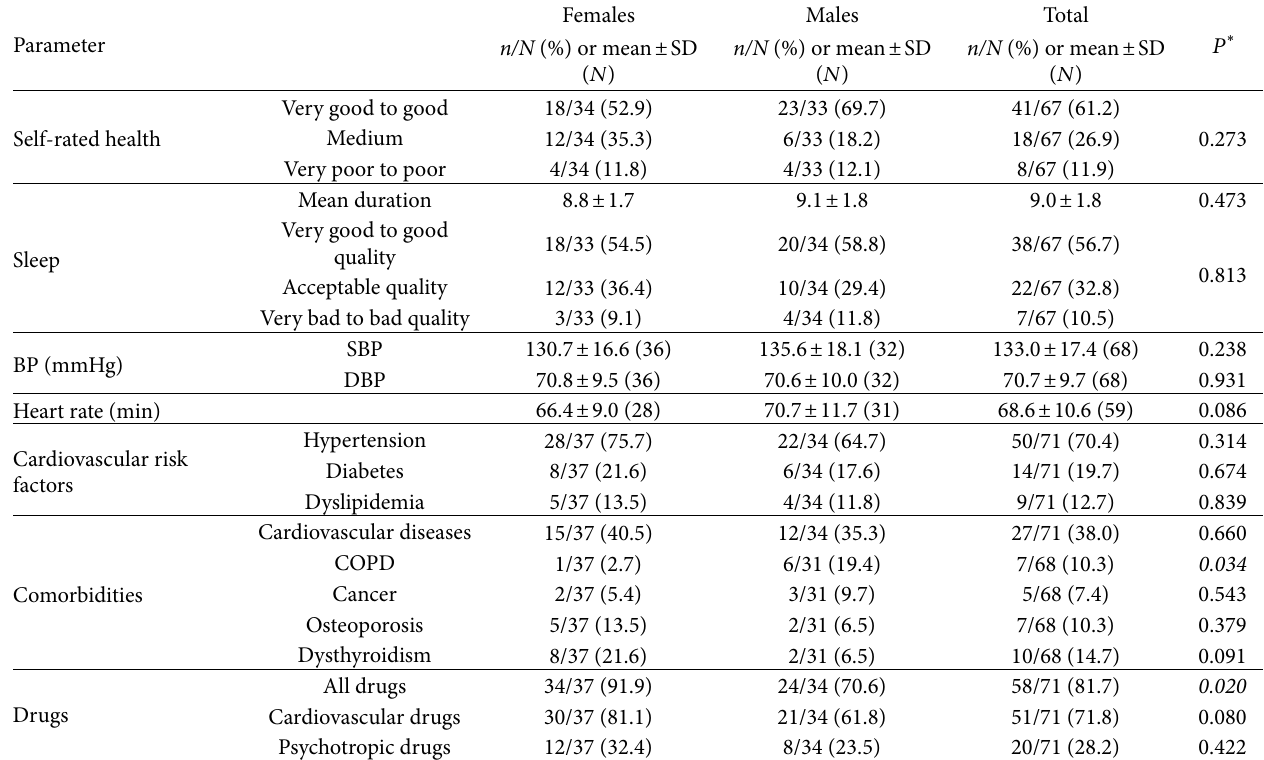
Table 3: Medical data of